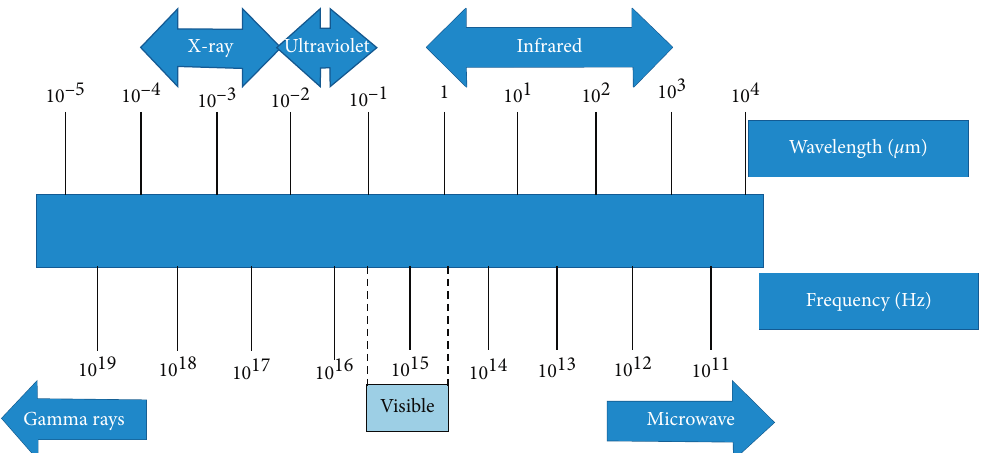
Gamma Figure 2: Electromagnetic radiation spectrum and wavelength